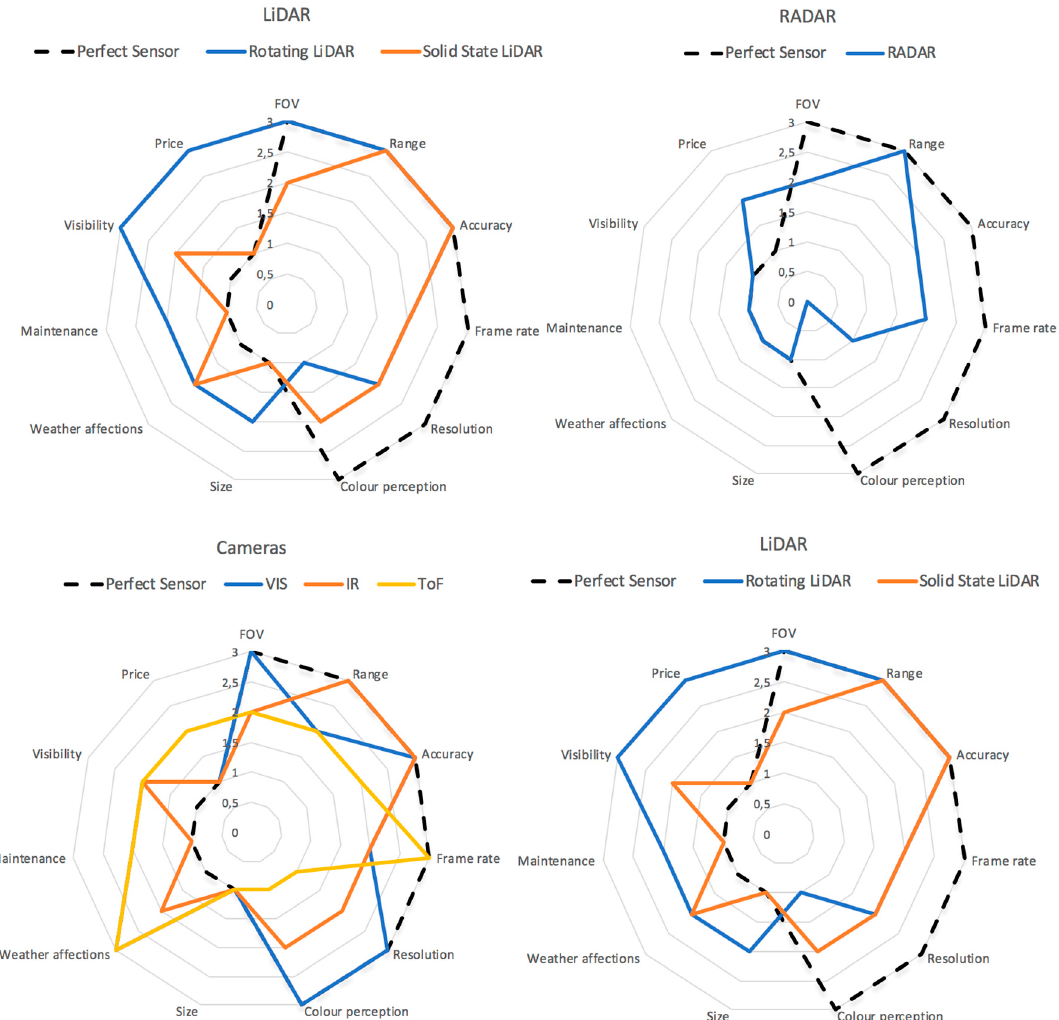
Figure 7. Comparison of the features of the different sensors used in environment perception systems.